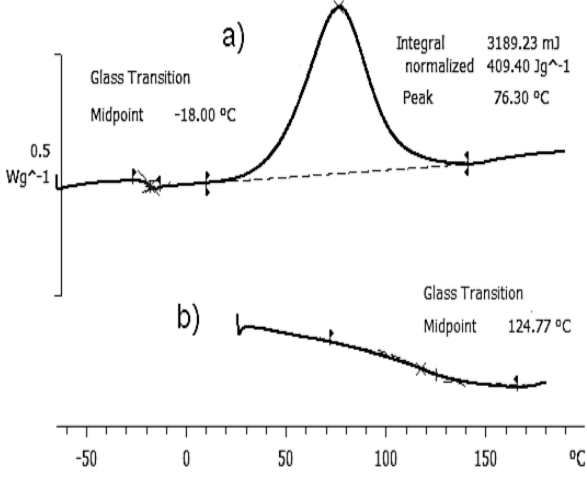
Figure 5. Thermogram of ELP sample: ( a ) first scan, at 2 K/min; ( b ) second scan, at 10 K/min. The exothermic direction is upward.